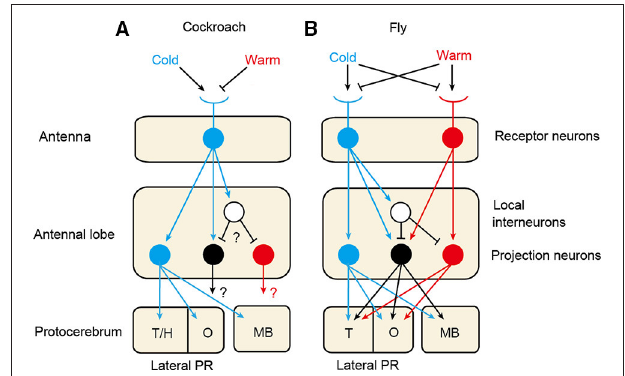
FIGURE 1 | Thermosensory systems in the cockroach (A) and the fruit fly (B). The cockroach is equipped with cold receptor neurons on the antennae (Nishikawa et al., 1992), whereas the fruit fly possesses cold and warm receptors (Gallio et al., 2011). In both species, axons of thermoreceptors terminate in a specific area at the posterior margin of the antennal lobe and form glomerular structures, called cold and warm glomeruli in the fly and cold glomeruli (DC1) in the cockroach ( Nishino et al., 2003; Frank et al., 2015). In the cockroach, cold projection neurons originating from the cold glomeruli exhibit excitatory responses to cooling. The cockroach also possesses warm and warm-cold projection neurons that exhibit excitatory responses to warming and to both warming and cooling, respectively, the morphologies of which have not been characterized ( Zeiner and Tichy, 2000; Fisher and Tichy, 2002 ). The fruit fly also possesses cold, warm and warm-cold projection neurons ( Frank et al., 2015; Liu et al., 2015). In both species, axons of these neurons project to calyces of the mushroom body (MB) and the olfactory area (O) and non-olfactory area of the lateral protocerebrum (PR) ( Frank et al., 2015; Nishino et al., 2003). In the cockroach, cold glomeruli form a cluster with moist and dry glomeruli, the latter two glomeruli receiving termination of moist and dry receptors, respectively (Nishikawa et al., 1995), and projection neurons originating from the cold, moist and dry glomeruli converge to the same olfactory and non-olfactory areas of the lateral PR ( Nishino et al., 2003). T/H: thermo- and hygrosensory area; T: thermosensory area of the lateral PR.